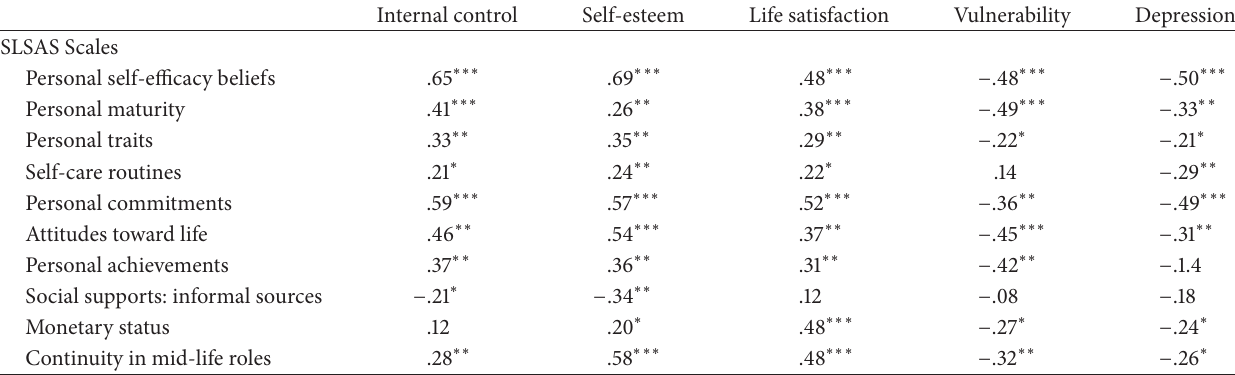
Table 3: Correlations of SLSAS scales with measures of internal control, self-esteem, life satisfaction, vulnerability, and depression. Internal